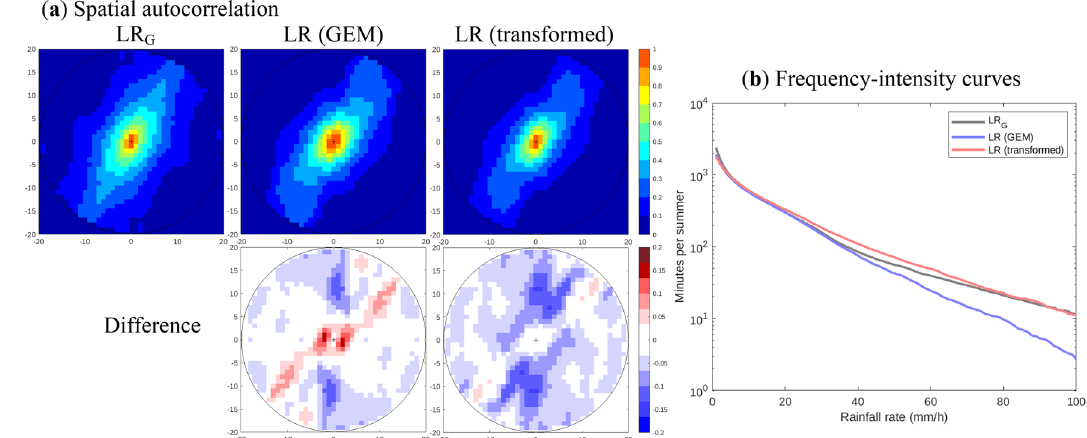
Fig. 3 a Median spatial autocorrelations in LR G , LR (GEM) and LR (transformed), and their differences with respect to LR G . b Frequency–intensity relationships for the three datasets in